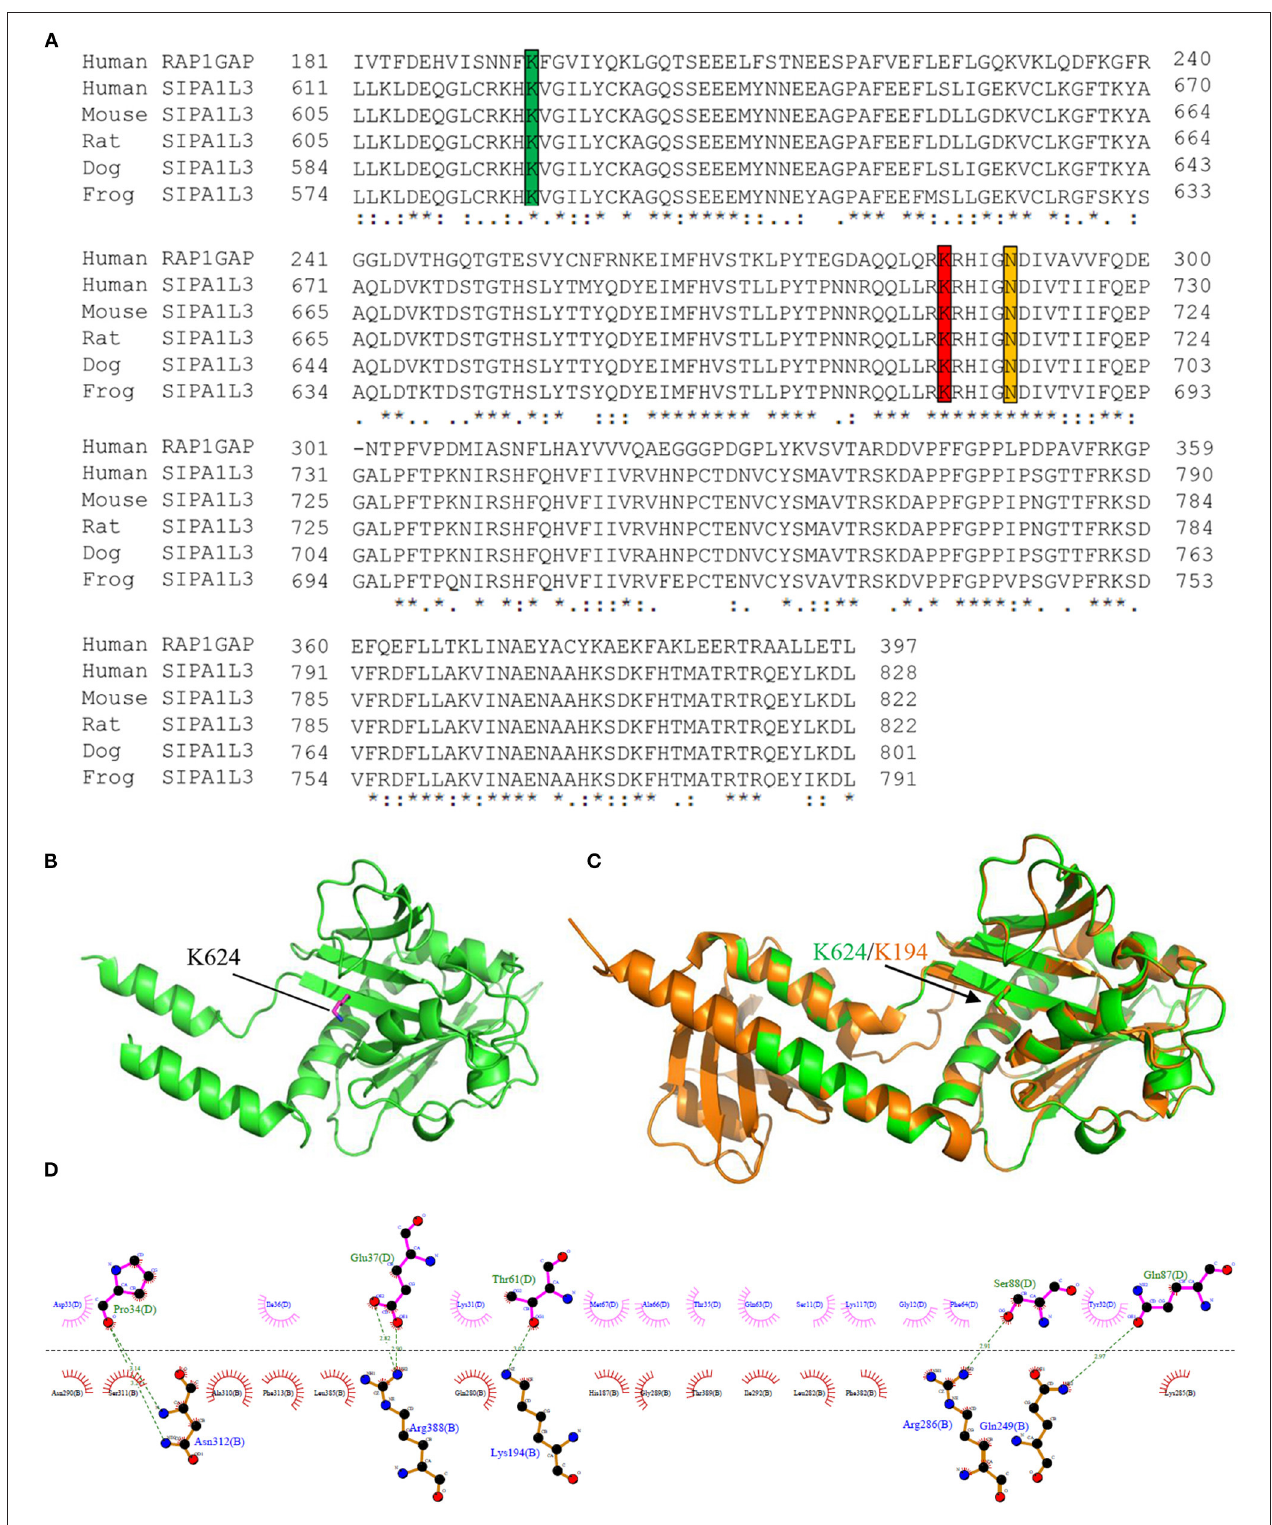
FIGURE 3 | The lysine residue 624 within the Rap GTPase-activating protein (RapGAP) domain of SIPA1L3 is highly conserved and shares homology with the lysine residue 194 of human Rap1GAP. (A) Alignment of RapGAP domain of SIPA1L3 of different species with the human Rap1GAP. The highly conserved lysine residues 194 and 285 and the key catalytic asparagine residue (Asn) 290 of Rap1GAP are marked by green, red, and yellow, respectively. (B) Homology modeling shows the